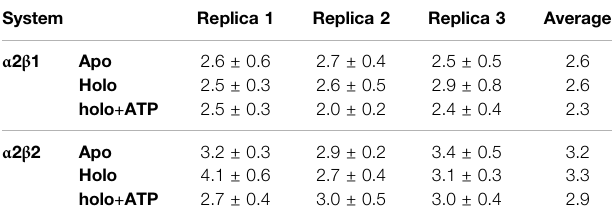
TABLE 1| RMSD and standard deviation(Å)determinedforthe protein backbone of the snapshots sampled along the last 500 ns of MD simulations performed forallsystems(apo,holoand holo+ATPstates)ofAMPKisoforms α 2 β 1and α 2 β 2. Values were determined using the energy-minimized holo+ATP species averaged for the last 200 ns of each simulation system as reference structure.